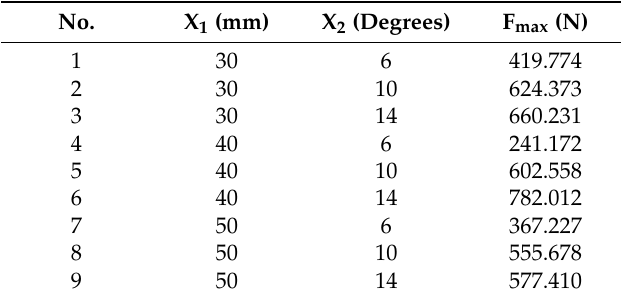
Table 3. Measured values of the maximum force F max